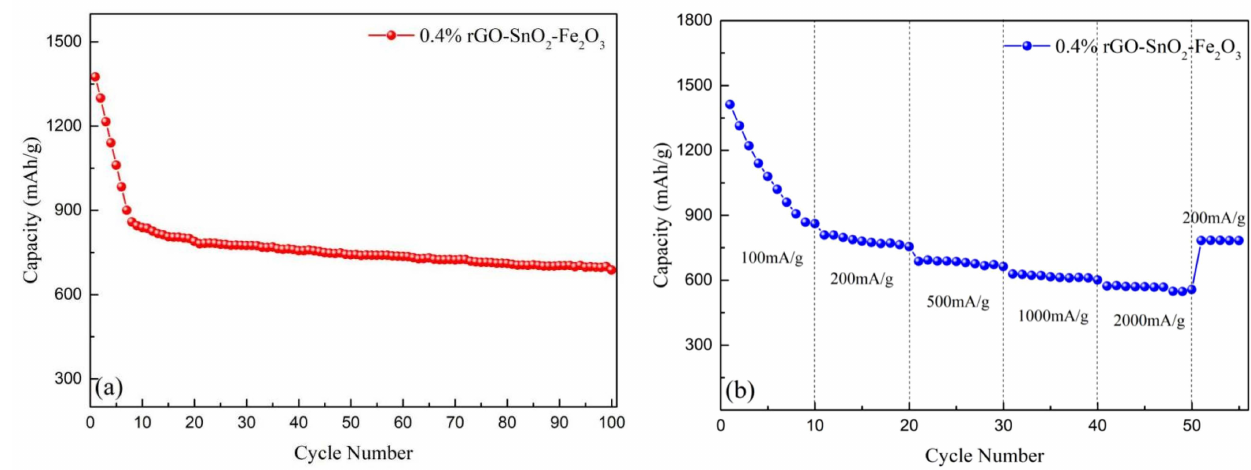
Figure 4. Cyclic performance diagrams of the 0.4%rGO-10SnO 2 -Fe 2 O 3 anode material. ( a ) A total of 100 discharge cycles; ( b ) Magnification